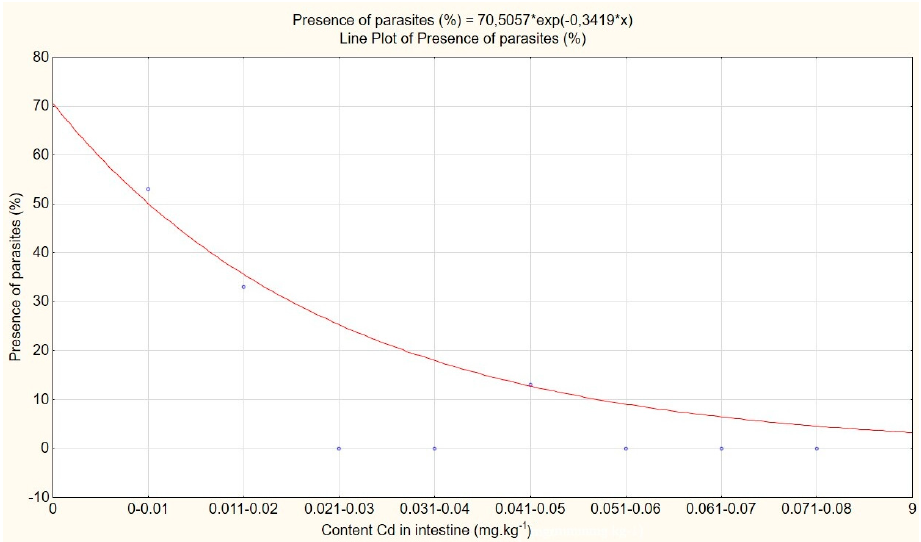
Figure 3. Prevalence of parasites and content of Cd in intestines of the host.